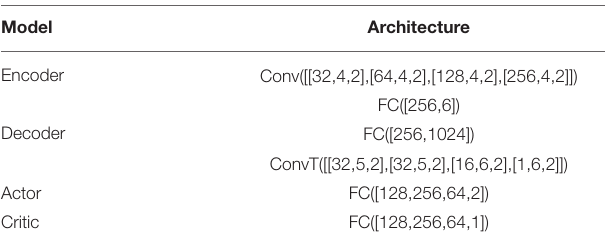
TABLE 1 | Model architecture.